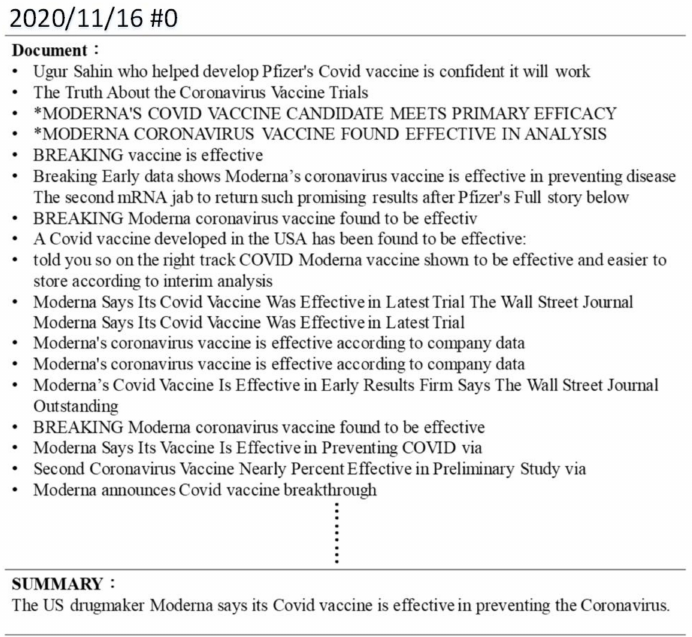
Figure A10. A sample resulting summary of formulated event topics (16 November 2020).